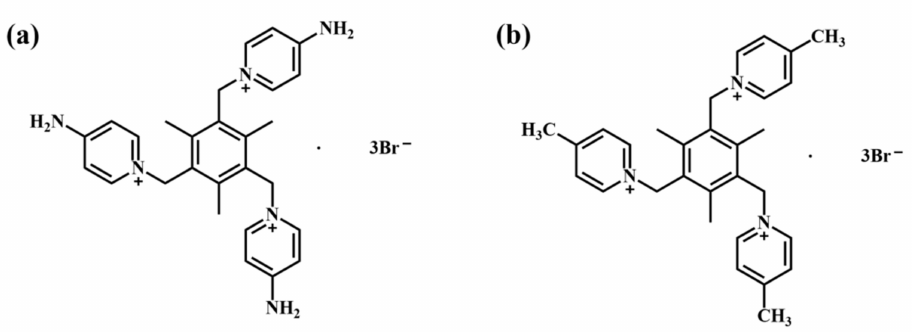
Figure 10. ( a ) The cationic template L1; and ( b ) the cationic template